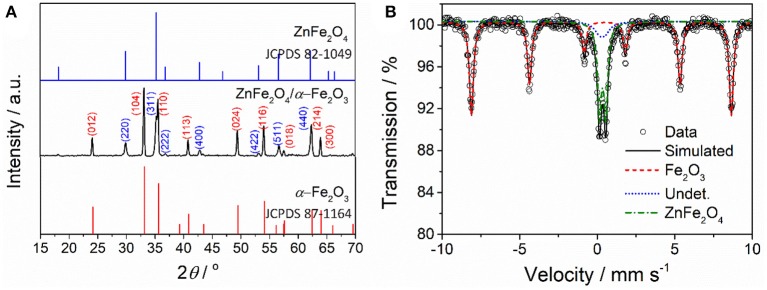
(A) XRD pattern and (B) room-temperature Mössbauer spectrum of the as-prepared ZnFe2O4/α-Fe2O3 nanocomposites.